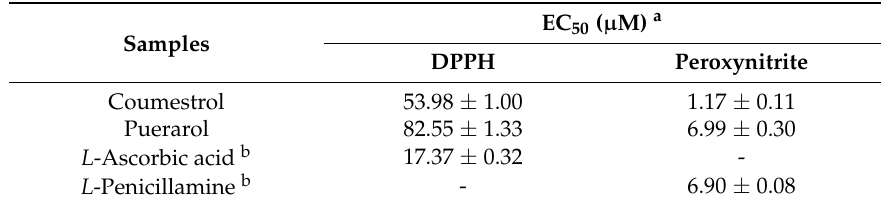
Table 1. 2,2-Diphenyl-1-picrylhydrazyl (DPPH) and peroxynitrite scavenging activity of coumestrol and